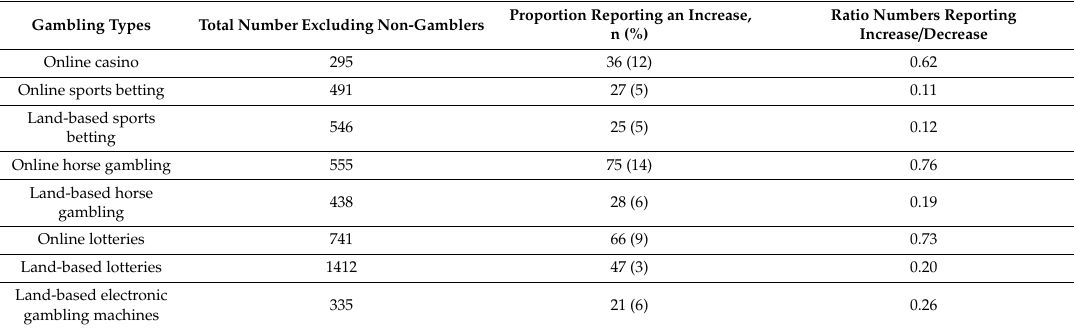
Table 4. Changes in specific gambling types. Calculated for the total of individuals excluding individuals reporting that they don’t engage in this particular gambling type, neither during COVID-19 nor prior to that. Number and percentages reporting an increase. Ratio of individuals reporting an increase vs a decrease for that gambling